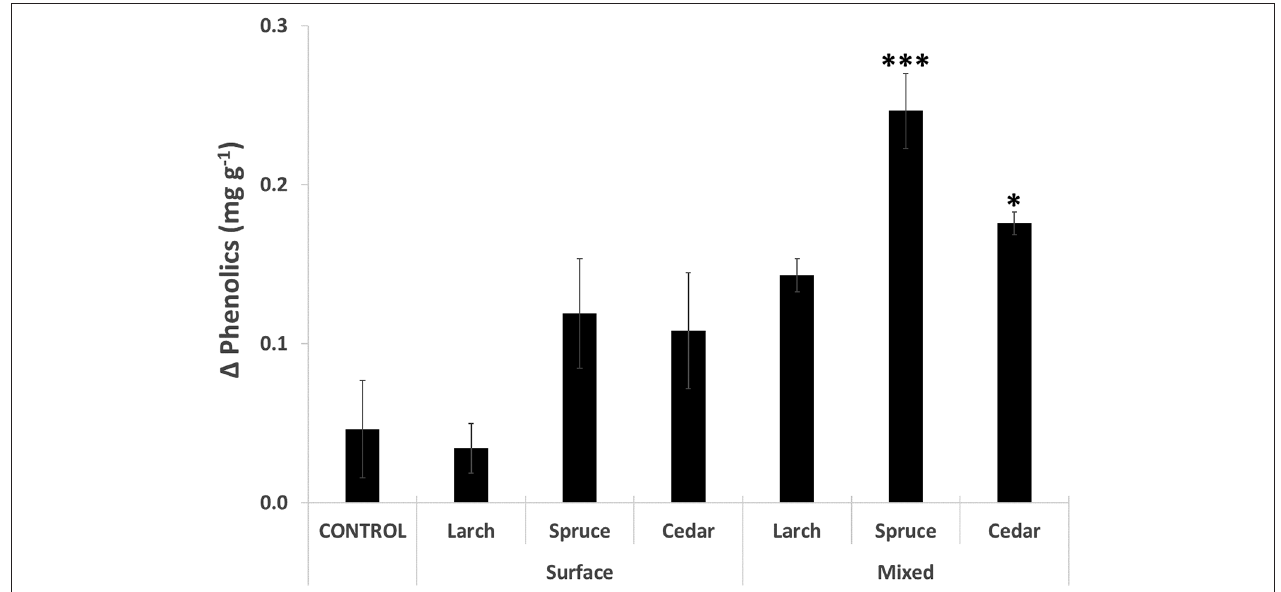
FIGURE 1 | Mean change in concentration of Phenolics over the period September 2013 to July 2014 ( n = 5). Significance levels: * p < 0.05, *** p <